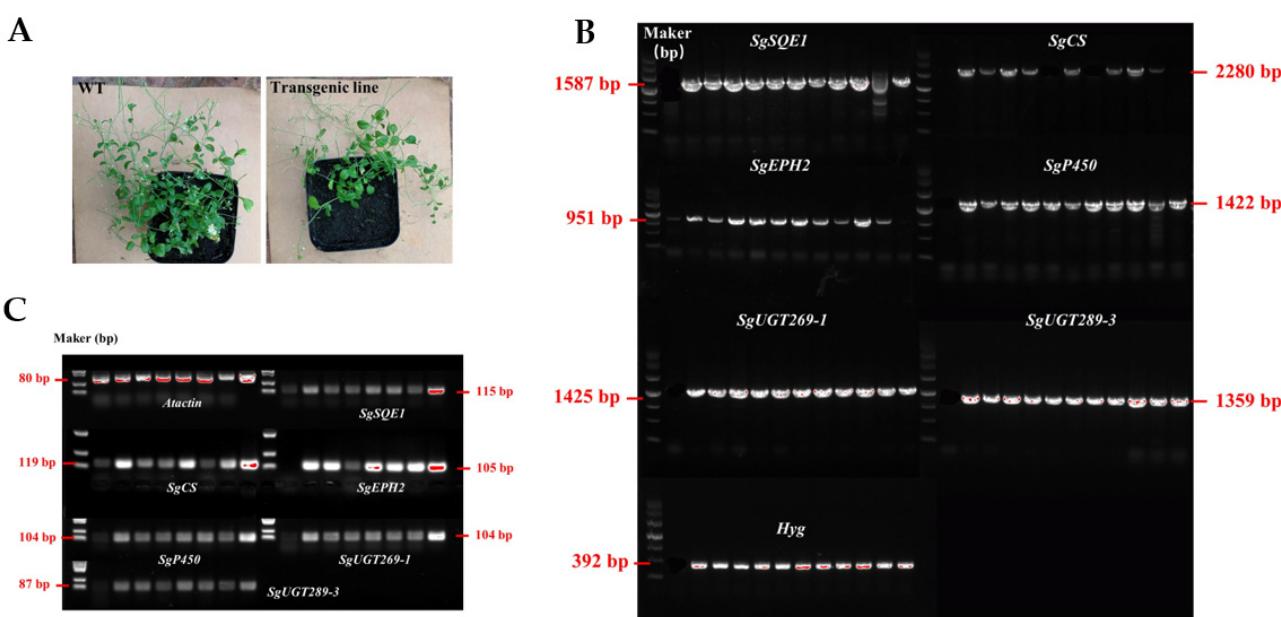
Figure 3. Molecular analysis of transgenic Arabidopsis lines. ( A ) Arabidopsis WT plants and transgenic lines. ( B ) PCR-based analysis of transgenic Arabidopsis lines. The lanes from left to right represent the WT, AA3, AA5, AA6, AA7, AU6, AU7, AU8, AU10, AU11, AU12, and AU13. DNA marker (4500 bp) is used in the figure. ( C ) RT-PCR detection of 6 mogrosides biosynthesis genes in the WT and transgenic Arabidopsis lines AA3, AA5, AA6, AU7, AU10, AU11, A12 (from left to right). The Atactin is used as an internal control.